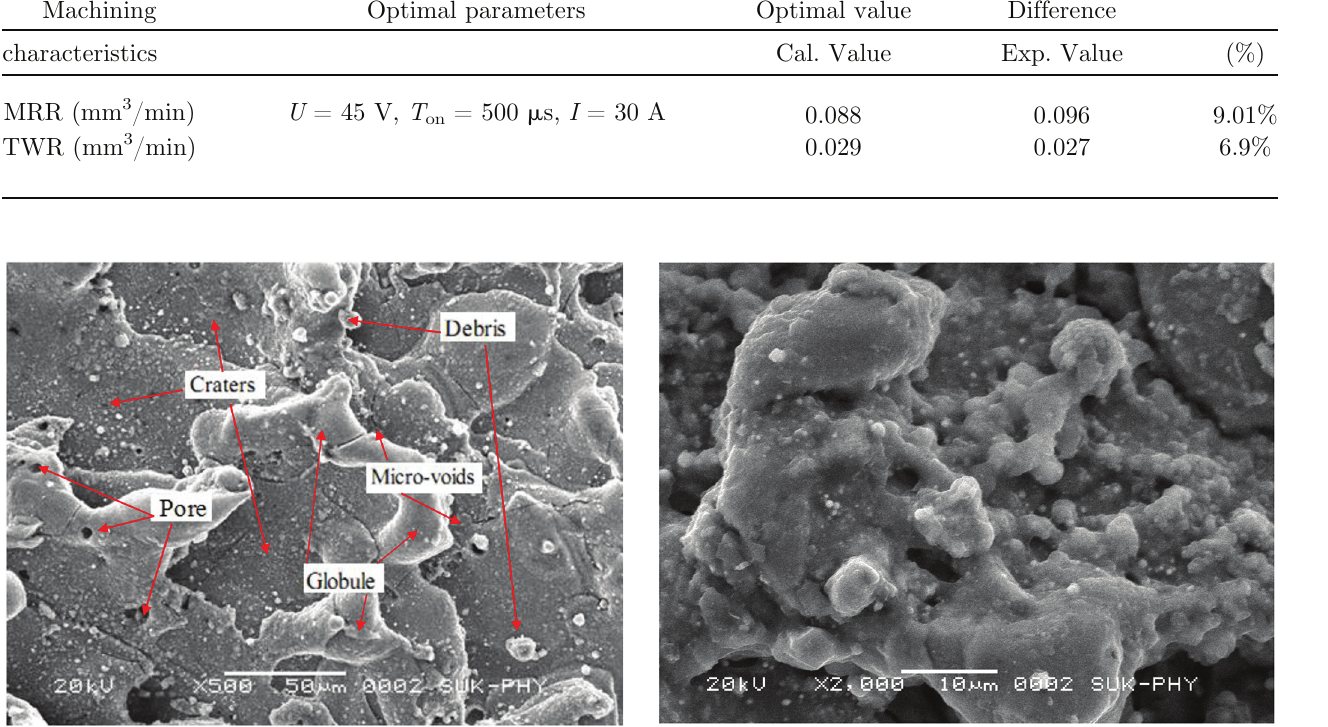
Fig. 9. Topography of machined surface. Fig. 10. Defects on the machined